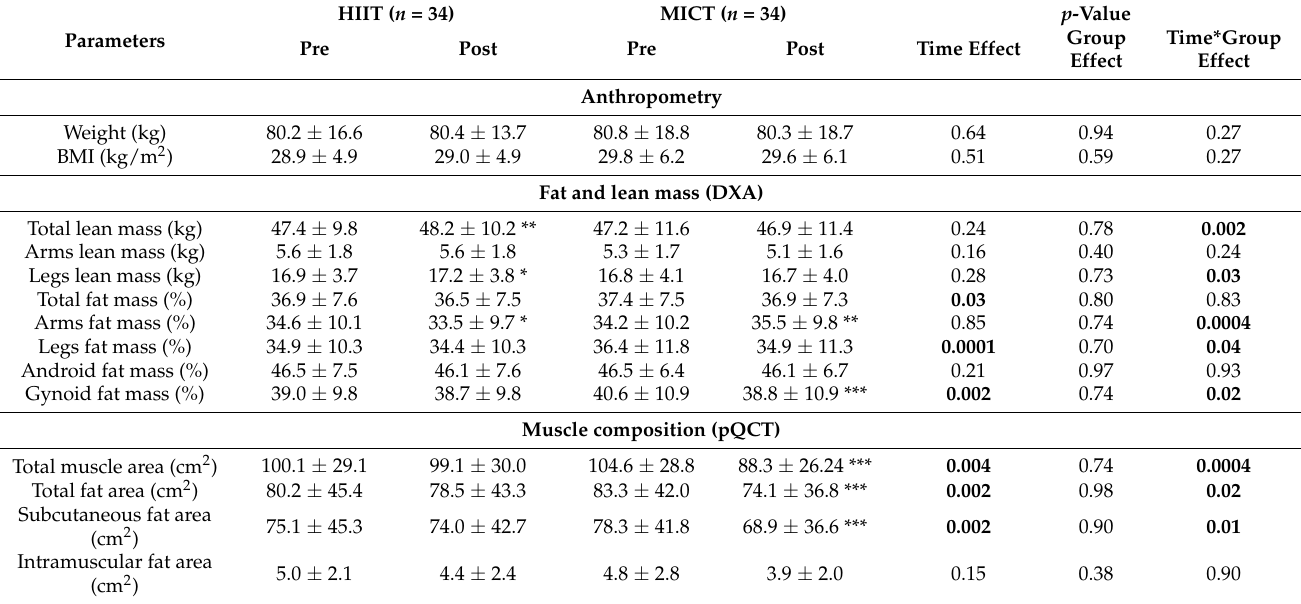
Table 3. Body composition parameters in obese older adults following 12 weeks of High-Intensity Interval Training (HIIT) and Moderate-Intensity Continuous Training